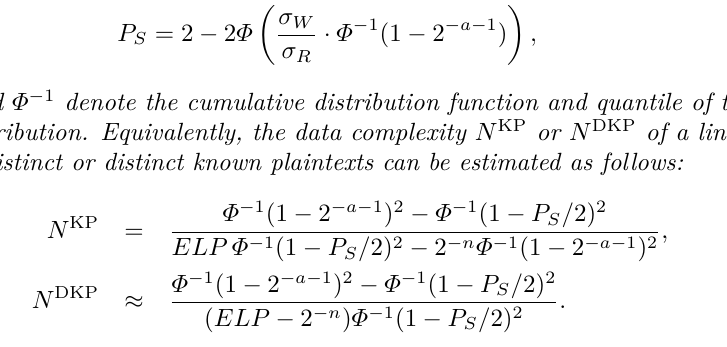
Figure 2: Left: distribution of ˆ c R and ˆ c W . Right: distribution of ˆ c 2 theoretical curves obtained from σ 2